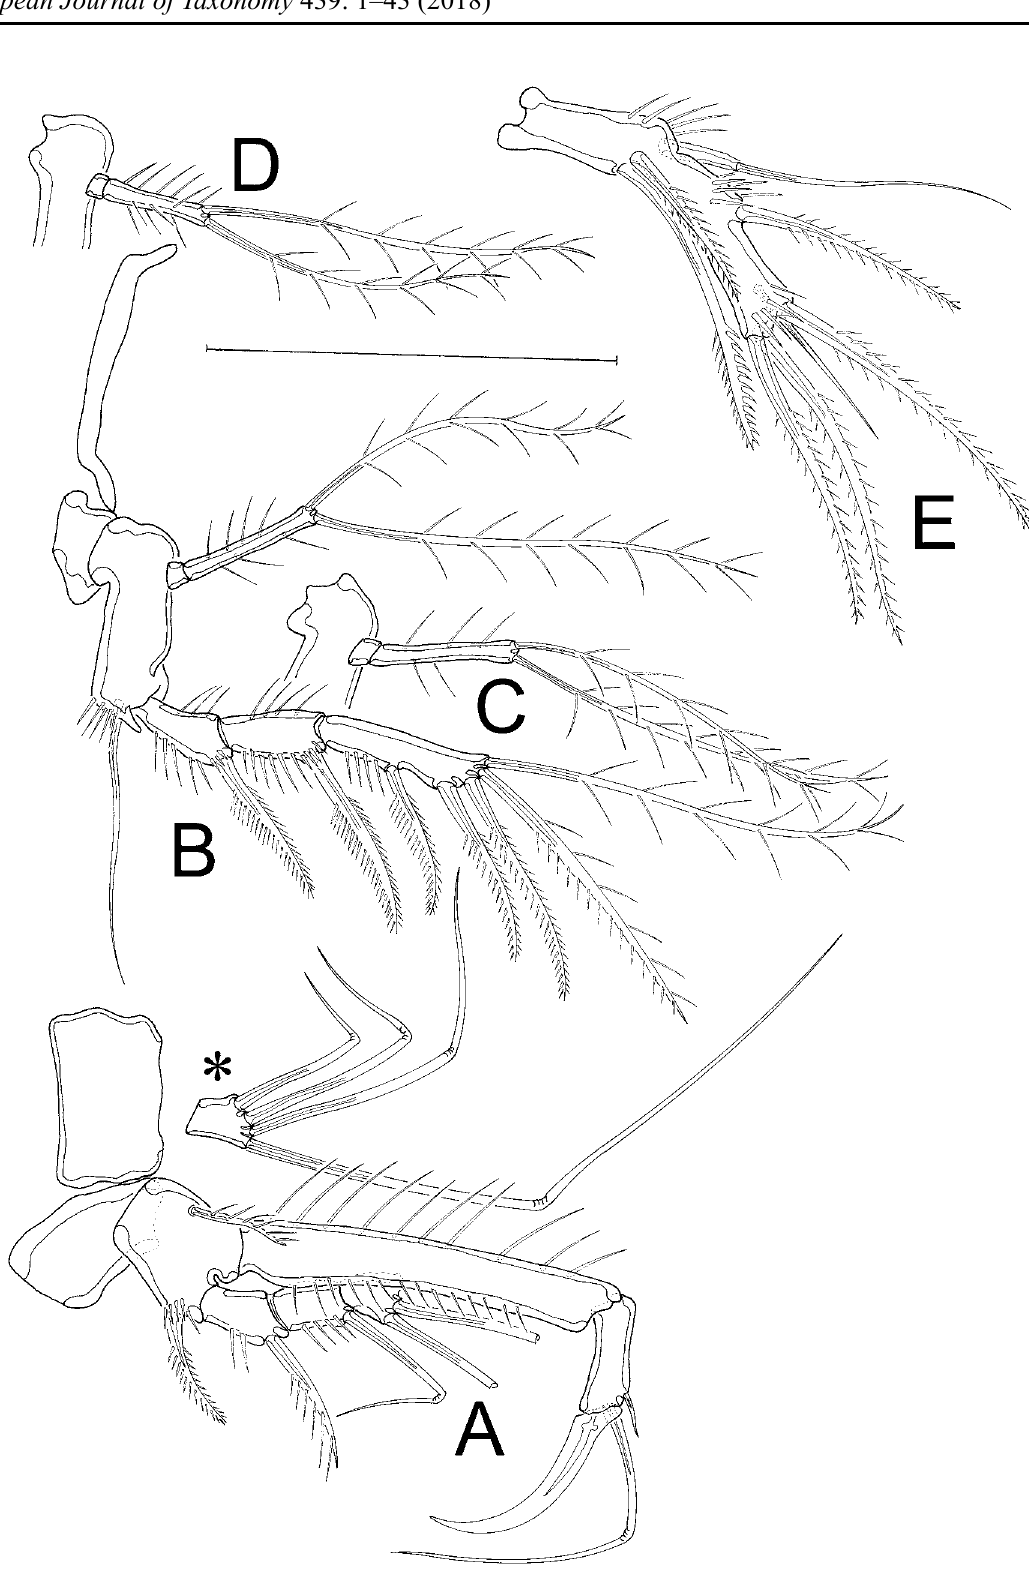
Fig. 14. Laophontodes gertraudae sp. nov., paratype, ♀ (SMF 37119/1). A . P1, asterisk (*) indicates exp-3 of counterpart. B . P2. C . P3 enp. D . P4 enp. E . P5. Scale bar= 50